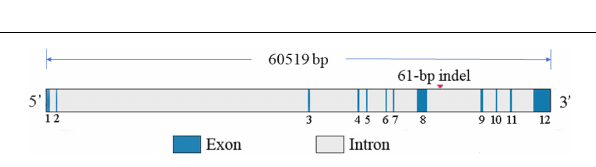
FIGURE 3 | RIN2 gene structural diagram and the location of the 61-bp indel.